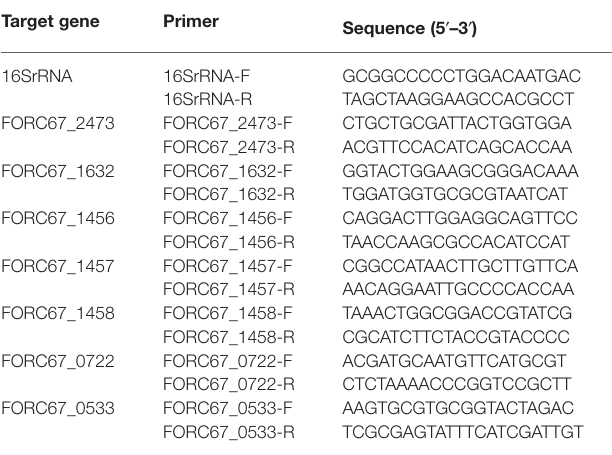
TABLE 1 | The primers used for qRT-PCR in this